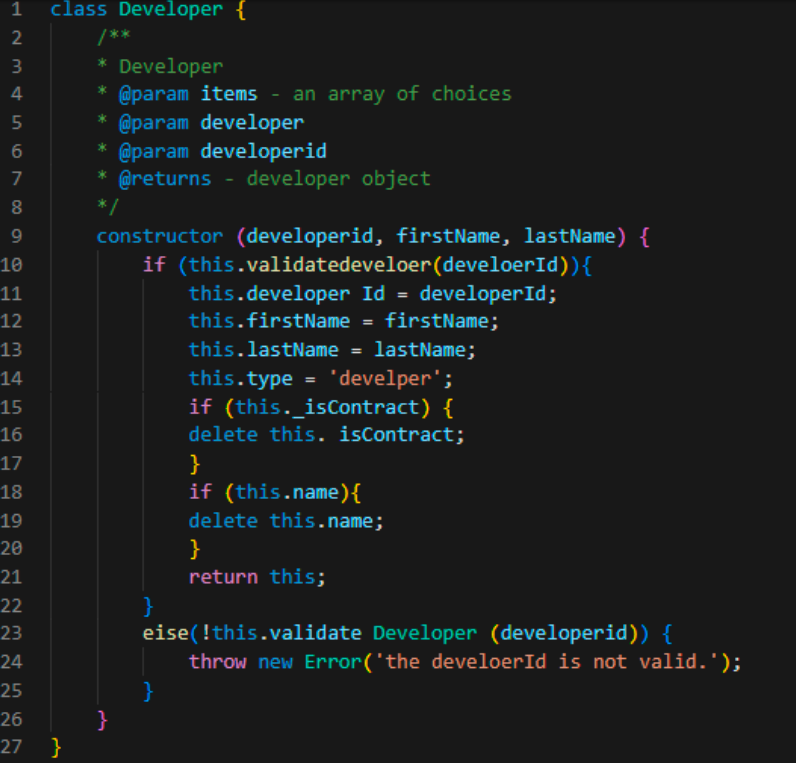
Figure 12. Smart contract developer class.